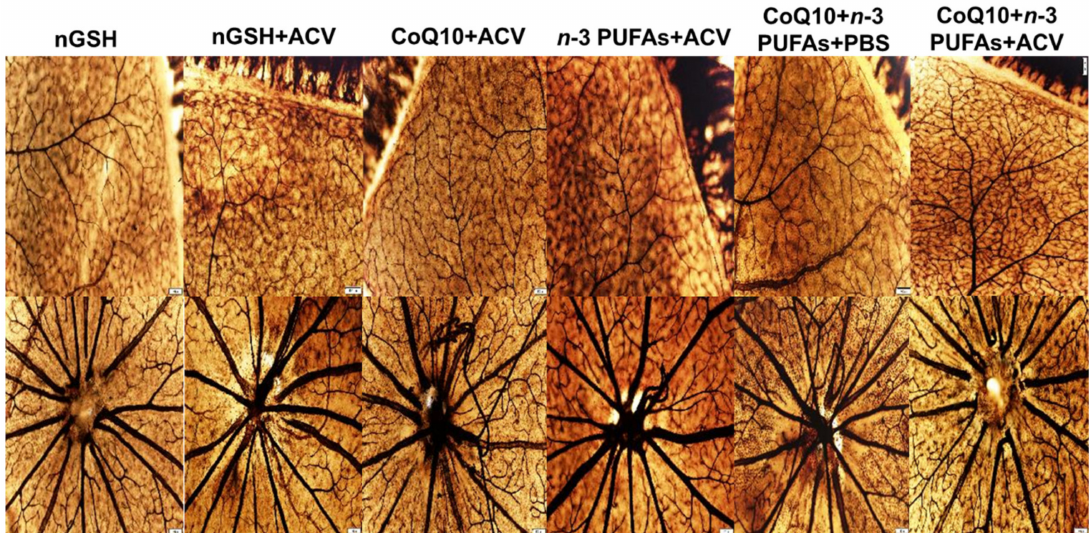
Figure 7. Representative ADPase-stained retinas from room air (RA) raised neonatal rats at postnatal day 21 (P21). The upper panels represent the periphery and the lower panels represent the optic disk. Images are 10 × magnification, scale bar is 100 µ m.